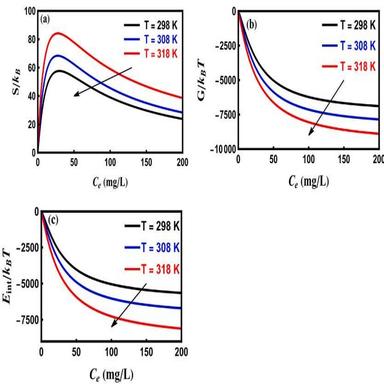
Evolution of (a) entropy, (b) Gibbs free energy, and (c) internal energy as a function of concentration for phenol adsorption on the nZVI@ACh composite.